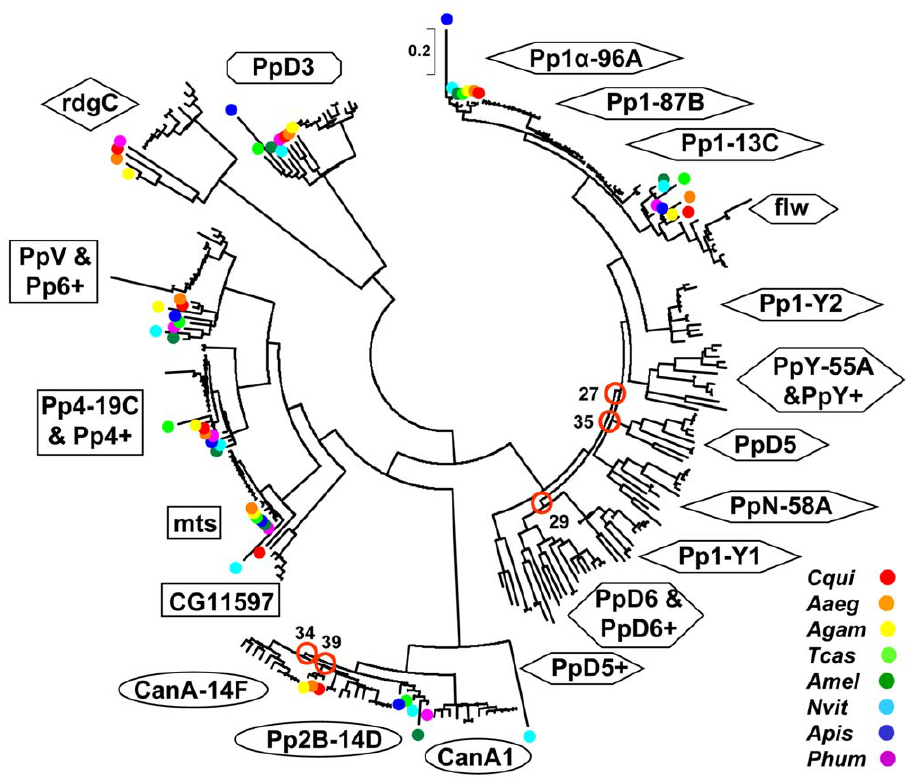
Figure 2. Phylogeny of PPP catalytic subunits in insects. The phylogeny of 287 insect PPP catalytic subunits is presented. Enzyme subfamilies are labeled in line with the D. melanogaster nomenclature (see Table 1 ). The color codes for the non- Drosophila species are given in the lower right corner, species abbreviations are listed in Table 2 . The scale indicates 0.2 amino acid substitutions per site in the primary structure. Uncertain branching points are circled and labeled with the appropriate bootstrap value. The following 8 short, partial polypeptide sequences were excluded from the comparisons: Dsim flw, Dana Pp1-Y1 , Dsec Pp1-Y2 , Dwil PpN58A , Dyak Pp2B-14D , Dvir Pp2B-14D , Dsim CanA-14F , Dsim rdgC .